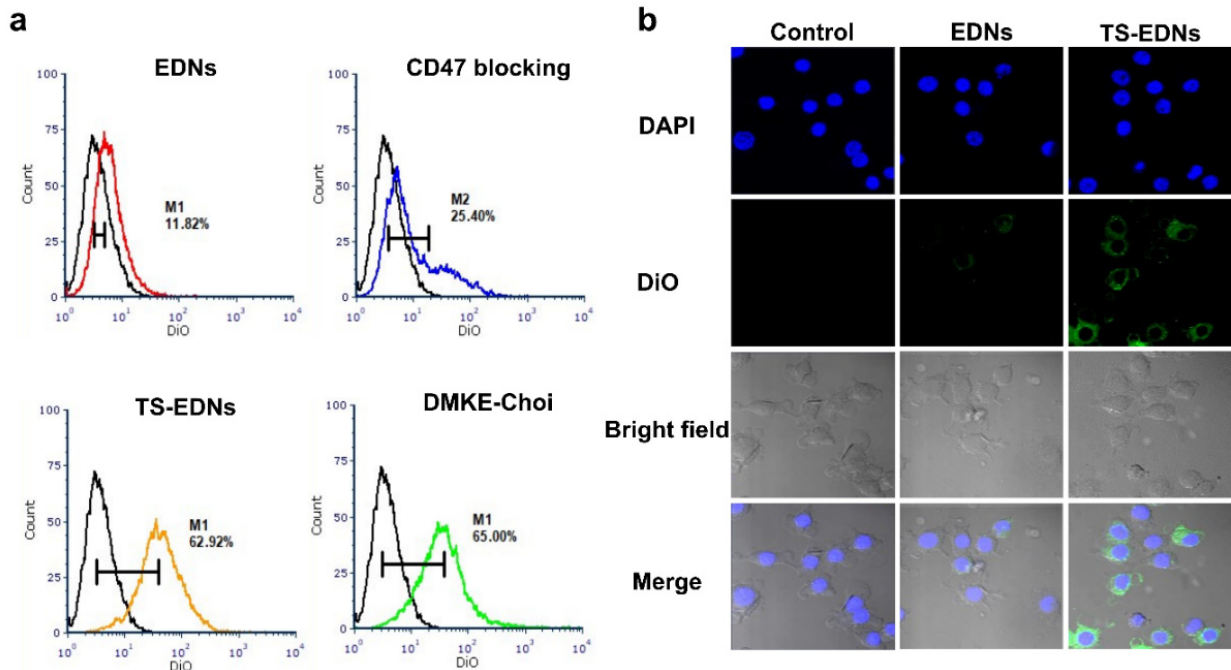
Figure 3. Interactions of EDNs with macrophages. Freshly prepared EDNs, CD47 ‐ blocked EDNs, trypsinized (TS) EDNs, and O,O’ ‐ dimyristyl ‐ N ‐ lysyl glutamate (DMKE) ‐ based cationic lipid nanoparticles were labeled with DiO. RAW 264.7 mouse macrophage cells were then treated with fluorescence ‐ labeled nanoparticles for 1 h at 37 °C and subjected to flow cytometry ( a ) and confocal microscopy ( b ). Magnification: ×400.